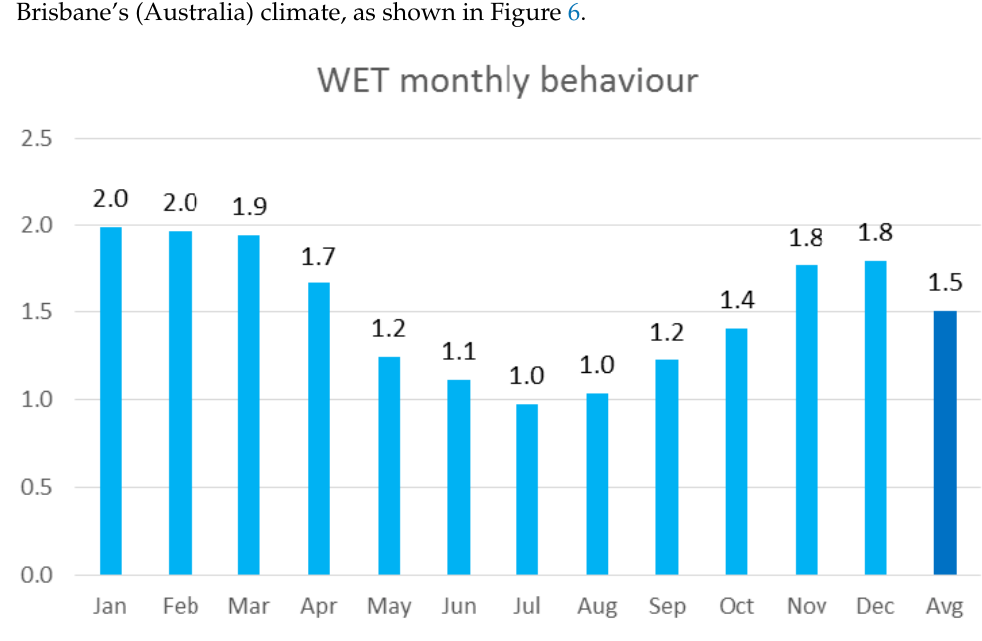
Figure 6. WET calculation for Brisbane’s climate.